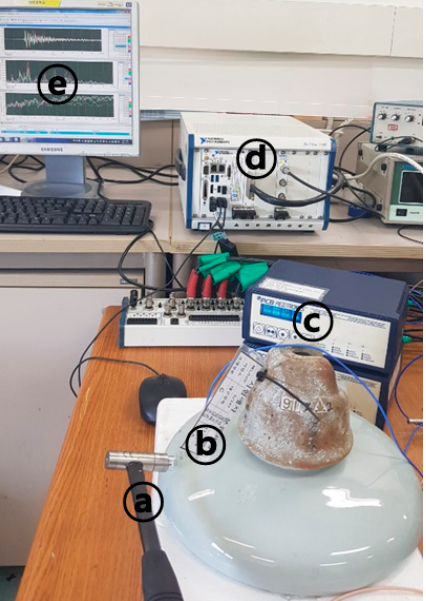
Figure 2. Experimental setup for frequency response function measurement of porcelain insulator. ( a ) Impact hammer; ( b ) accelerometer; ( c ) signal conditioner; ( d ) DAQ; ( e ) data visualization.